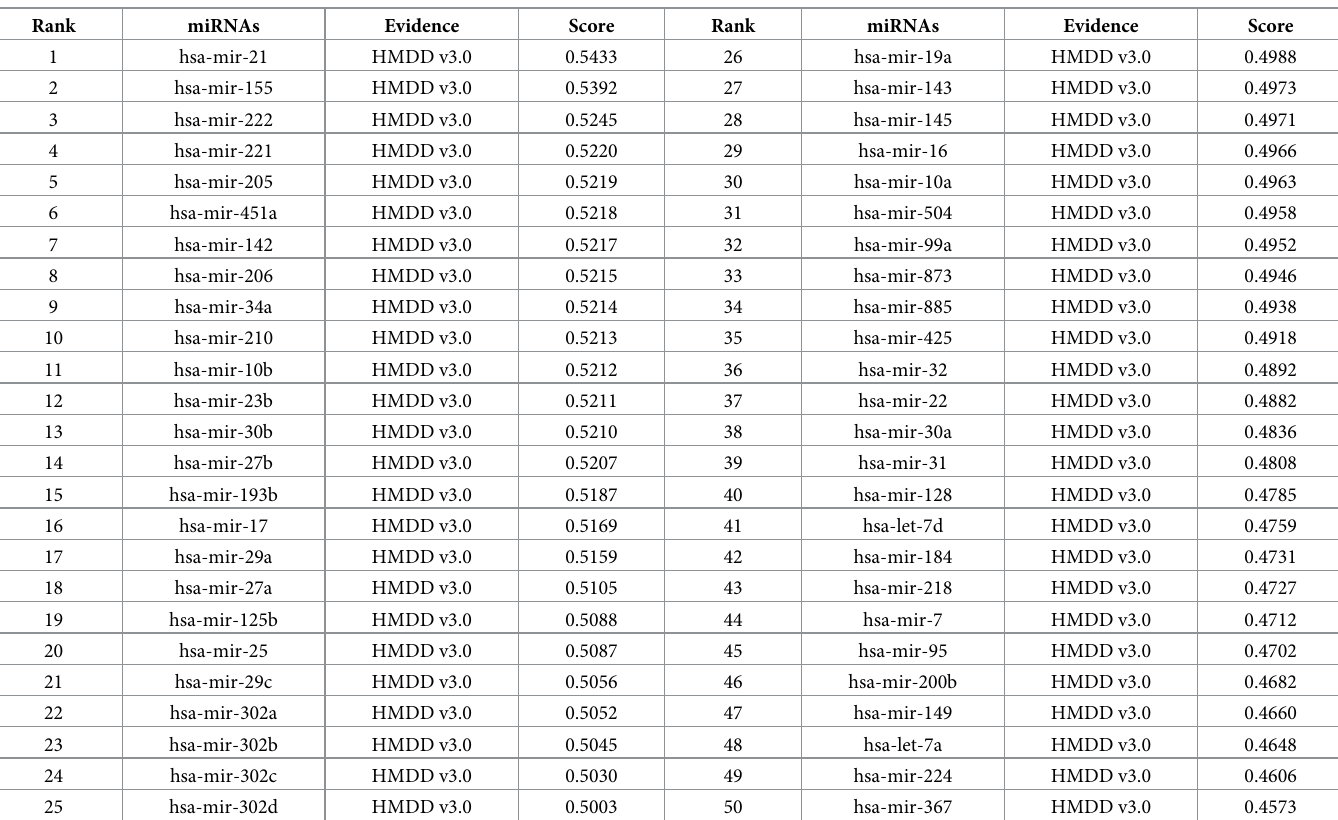
Table 7. Validation results of predicted associations for glioblastoma as an unknown